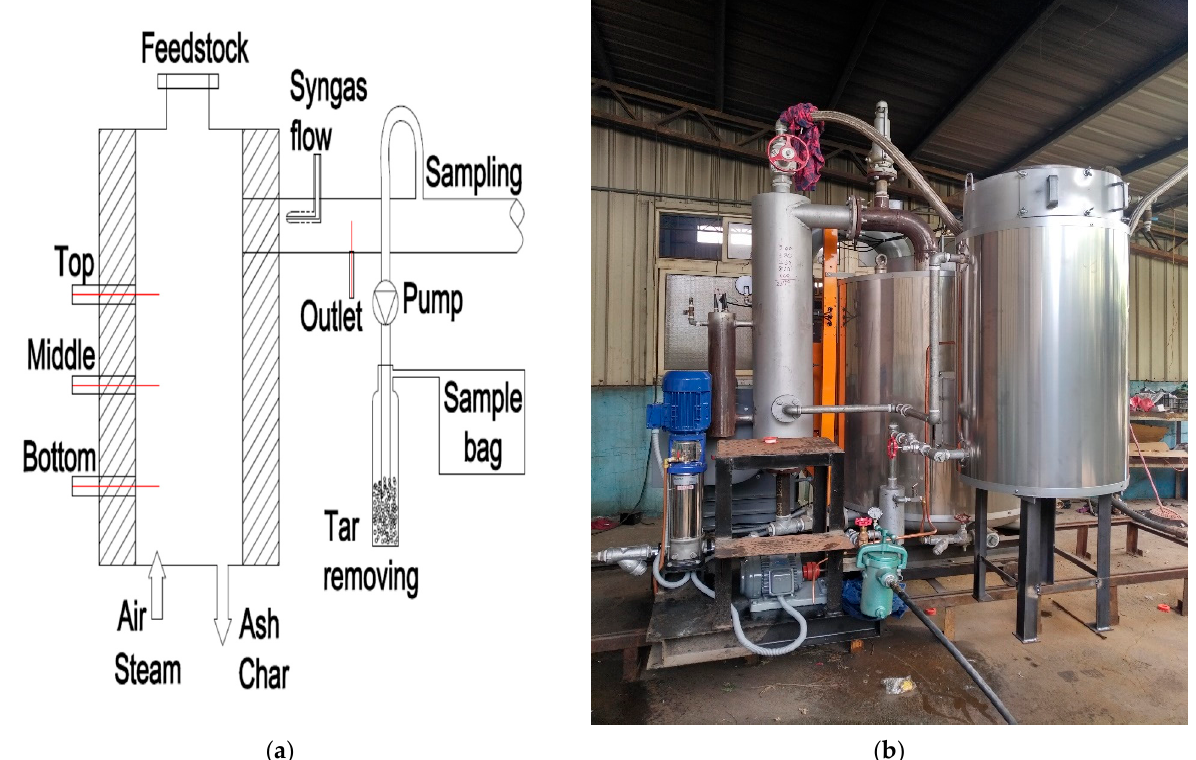
Figure 2. ( a ) Model of the gasifier; ( b ) boiler.